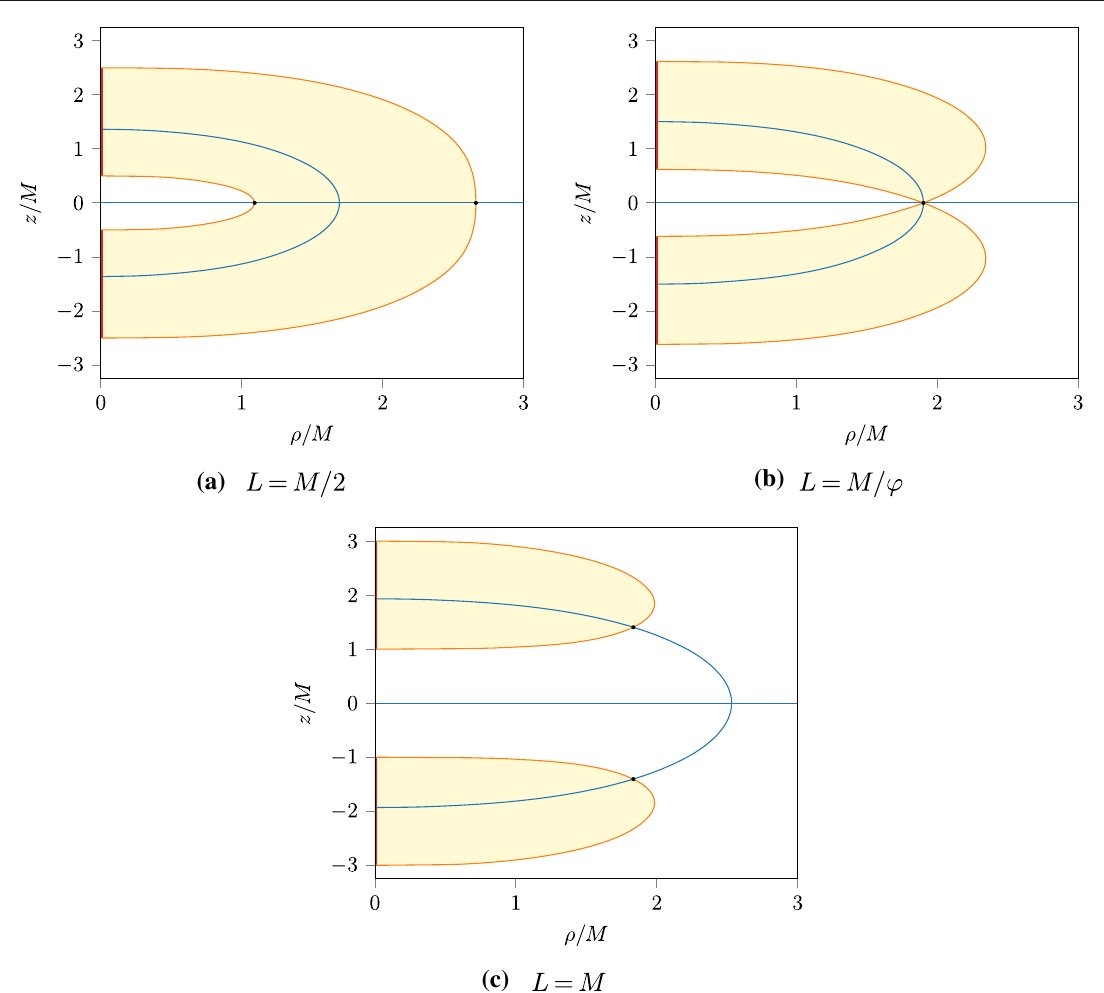
Fig. 3 Plotsshowingthepoints (ρ, z ) atwhich ∂ ρ H (ρ, z ) = 0(orange curves) and ∂ z H (ρ, z ) = 0 (blue curves), for three different values of L as indicated. The intersection points (black dots) correspond to LRs.